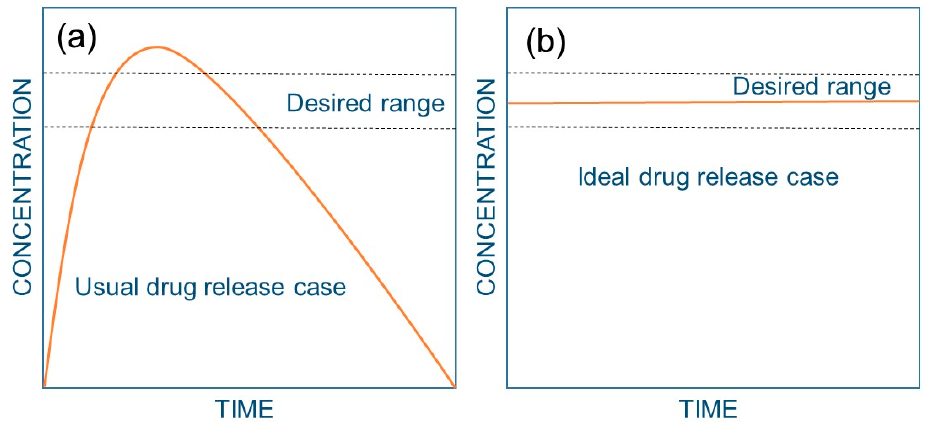
Figure 9. Plasma drug levels as a function of time for the usual and ideal case for drug administration. ( a ) Usual case; i.e., injection or pill: the plasma drug level reaches a peak as the drug enters the bloodstream. However, the drug quickly diminishes and falls to a low or non-existent level, dictating repeated drug administration to enable re-entry into the therapeutic range, resulting in a saw-tooth pattern of plasma drug levels. When the drug is above the desired range, it may cause unwanted side effects; when the drug is below the desired range, it no longer has a therapeutic effect. ( b ) Ideal case: a controlled-release system causes the drug level to be within the desired range for specified periods (days or months).